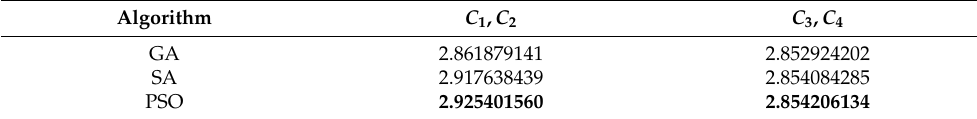
Table 3. Optimization results obtained by the compared algorithms. The best values of C obtained in the first experiment are written in